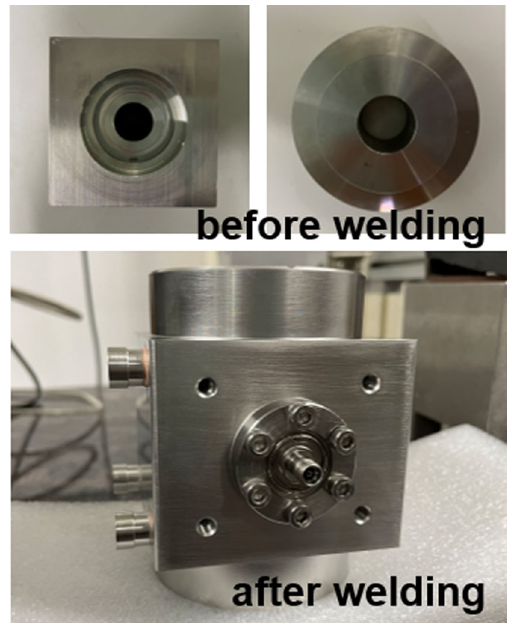
FIG. 6. BAM prototype: two parts of the pickup body and the assembly after